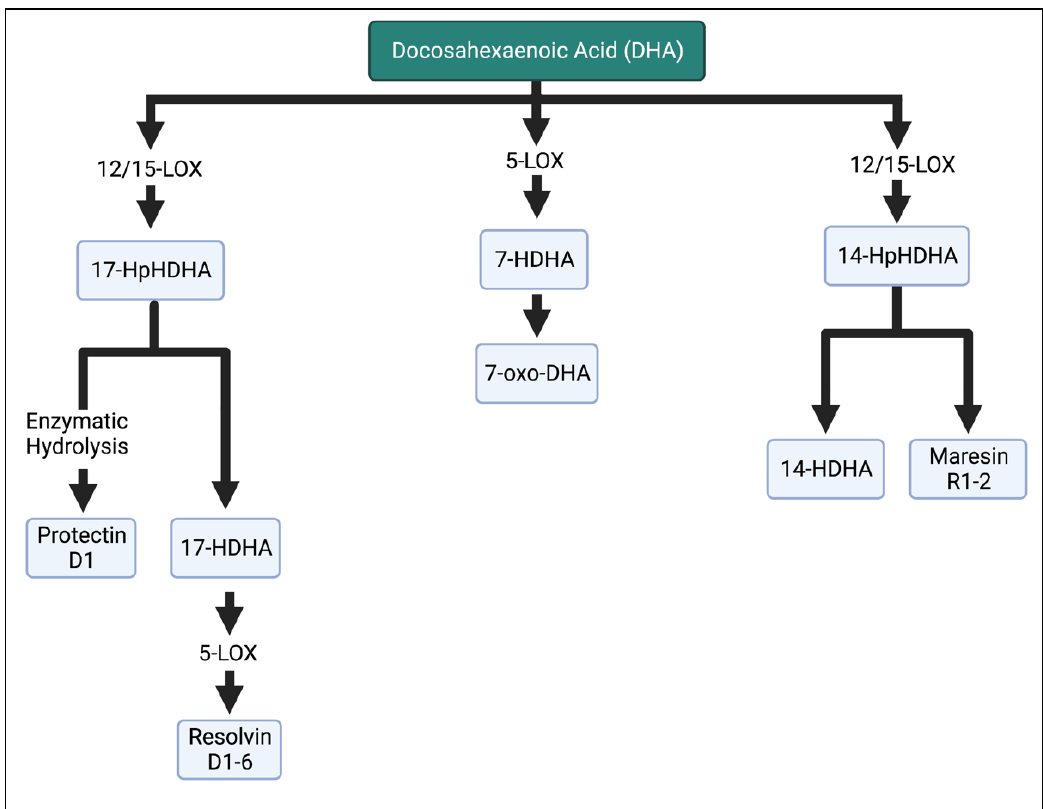
Figure 6. Metabolism of DHA in the LOX enzymatic pathway. DHA is metabolized into resolvins, maresins, and protectins, which are involved in the anti-inflammatory properties of n-3 FAs. HpHDHA, hydroperoxydocosahexaenoic acid; HDHA, hydroxydocosahexaenoic acid; DHA, docosahexaenoic acid. The Figure was created in BioRender.